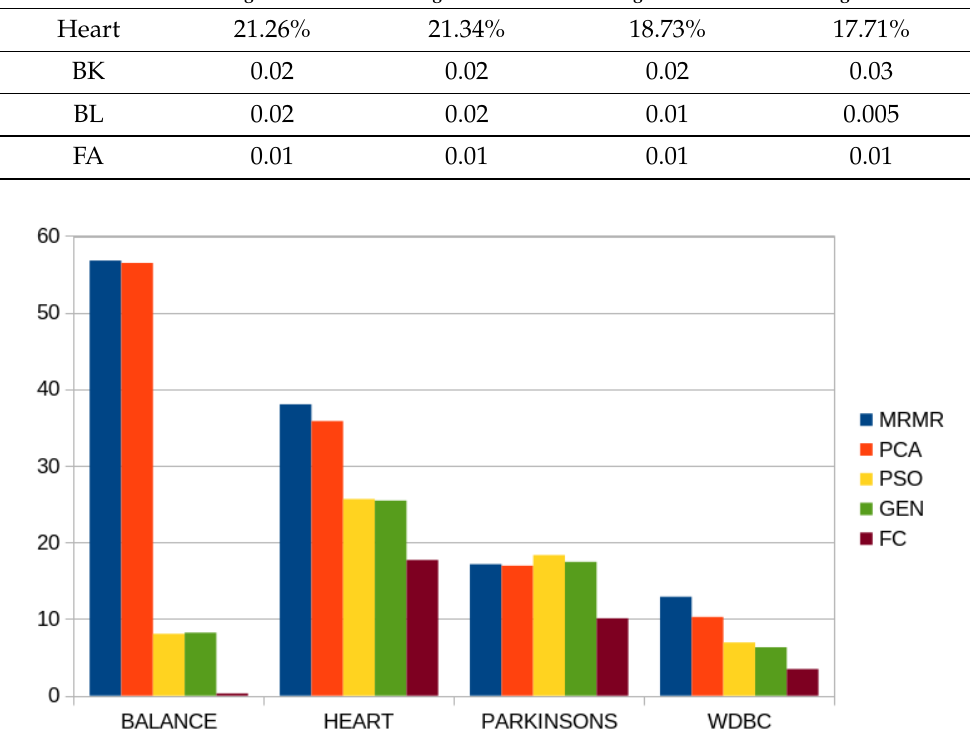
Figure 2. Graphic representation of some of the classification